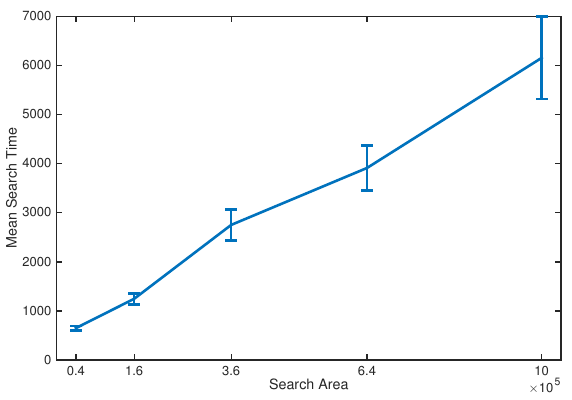
Figure 4. Mean search time for N = 5 platforms when varying the side length of the search area from 200 to 1000. The error bars show the 95% confidence interval for the estimate of the mean.